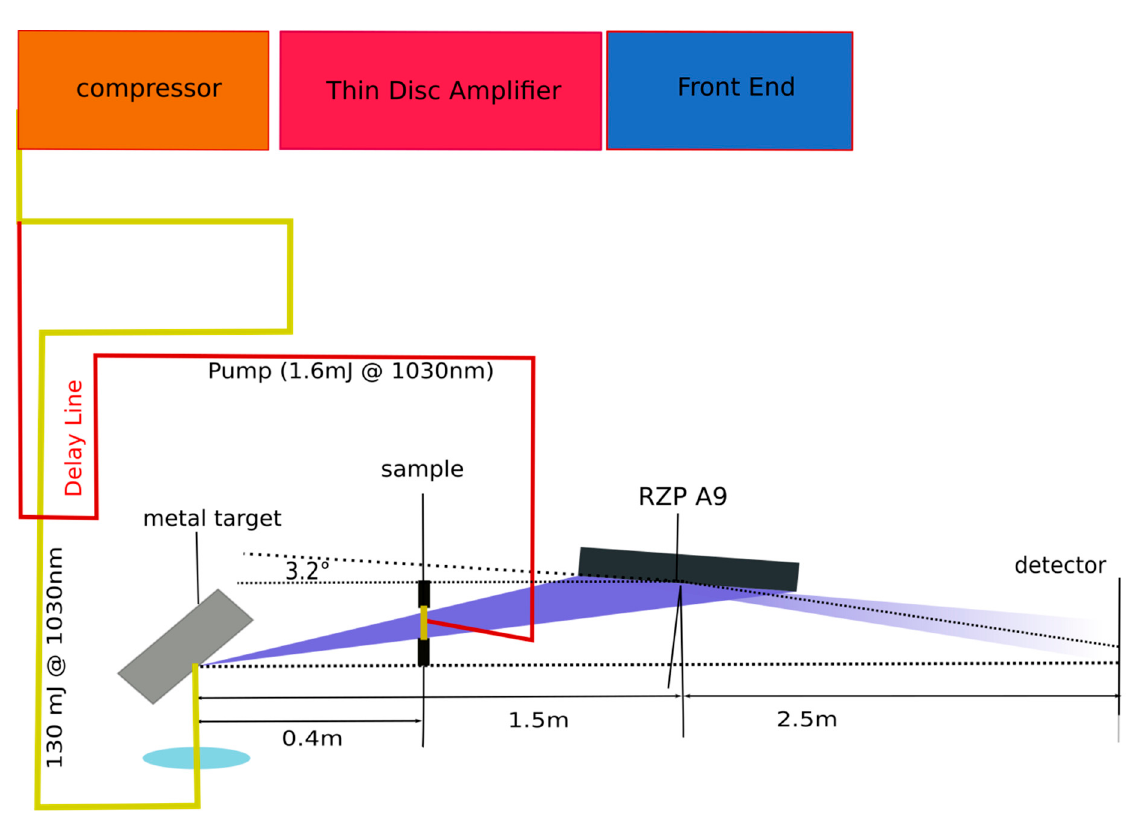
Figure 5. Scheme of the tr-NEXAFS setup using a picosecond driver laser and a reflection zone plate on a bent substrate.